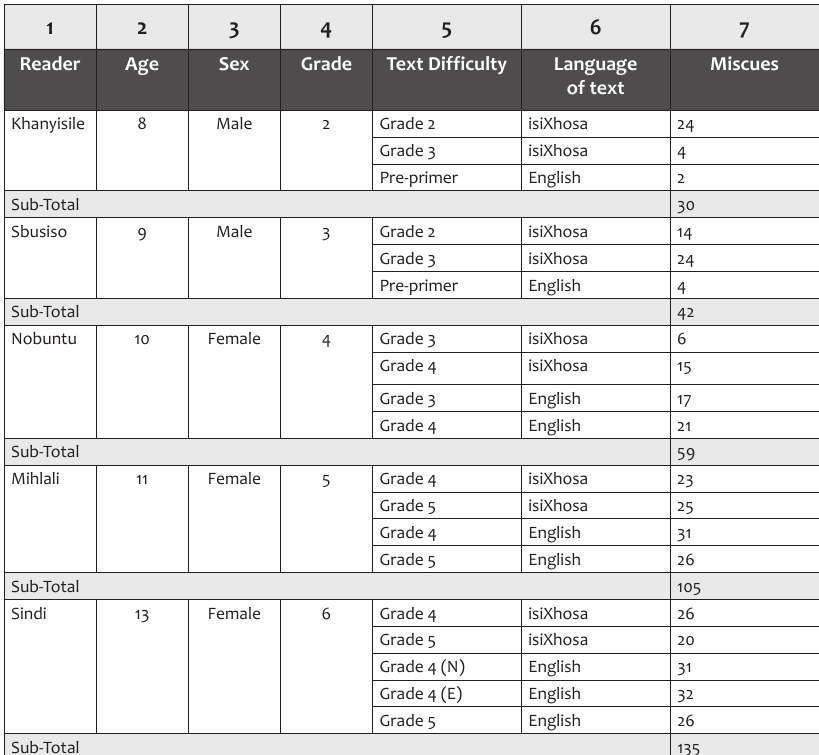
Table 1: Readers’ biographical and reading